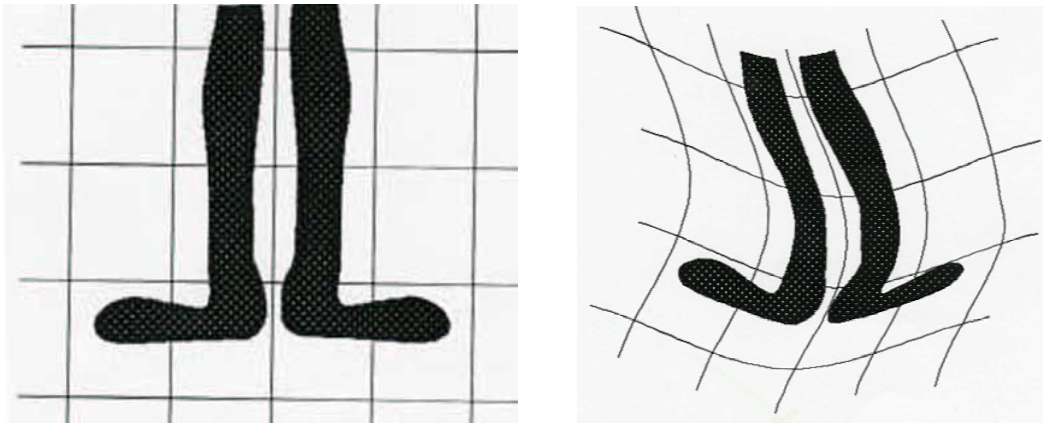
FIGURE 3. Without a firm metric (right), the organisms form and other high-level qualities will not be able to be established or maintained in a system only based on local